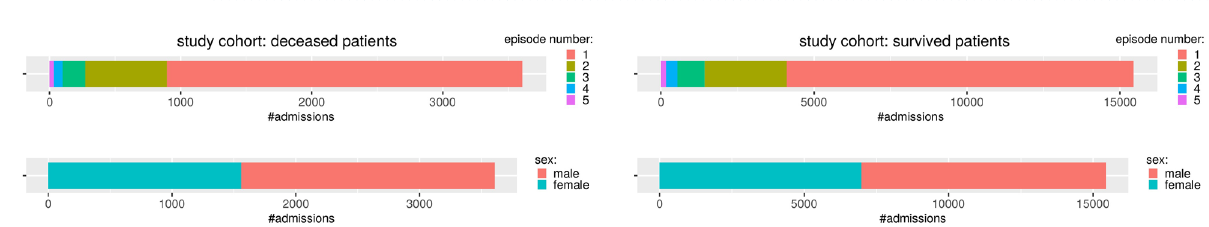
Figure 3. Study cohort: stacked barplots of the distribution of categories. Distribution of sepsis episode number and sex of the admissions of patients who deceased (left) and survived (right). Admissions of survived patients: positives data instances (class 1). Admissions of deceased patients: negative data instances (class 0).